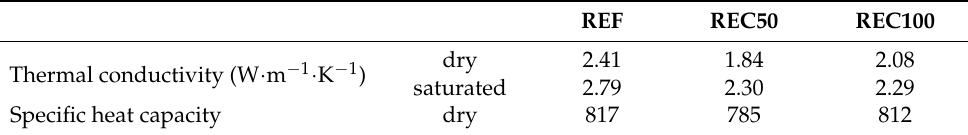
Table 2. Thermal transport and storage